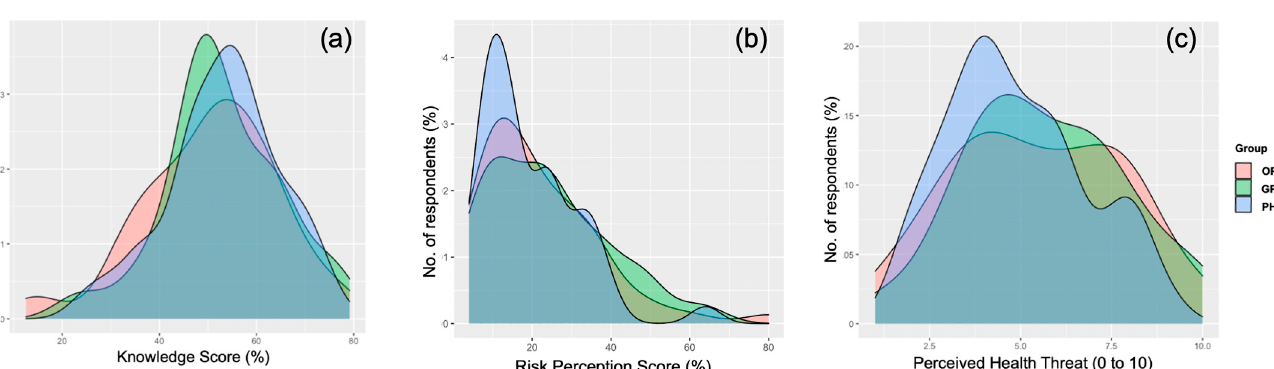
Figure 2. Density plots for: ( a ) Knowledge Score in 156 Italian physicians participating into the survey; ( b ) Risk Perception Score (RPS); ( c ) Perceived burden on National Health Service of Monkeypox. RPS was substantially skewed (D’Agostino–Pearson’s normality test p -value < 0.001), while Knowledge Score ( p = 0.109) and perceived threat ( p = 0.389) were not. Dotted line represents median value (50.0%, 20.0%, and 5.0, respectively).